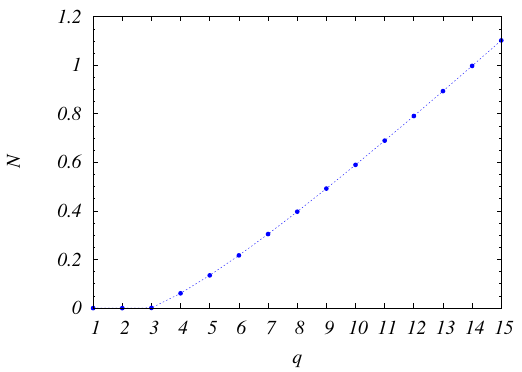
Figure 8: Negativity for two spins at the edges of a Motzkin chain of size L = 1000, as a function of the number of colors q